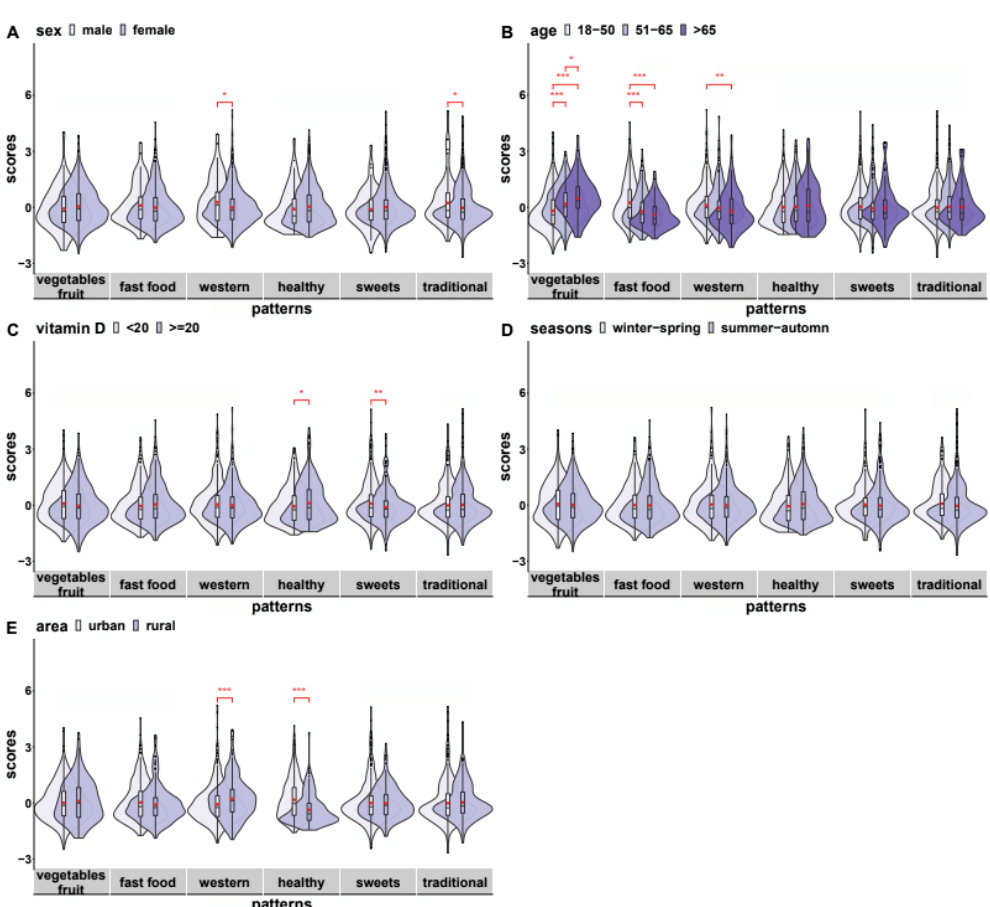
Table 3. Correlation between dietary patterns and continuous variables.